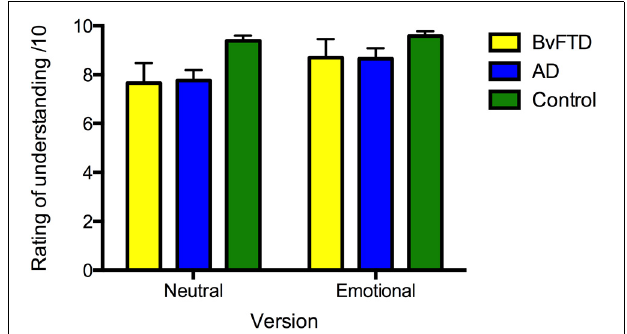
FIGURE 1 | Ratings of subjective level of understanding of the neutral and emotional versions of the story in: behavioral-variant frontotemporal dementia (bvFTD), Alzheimer’s disease (AD), and controls. Maximum rating is 10. Error bars represent standard error of the